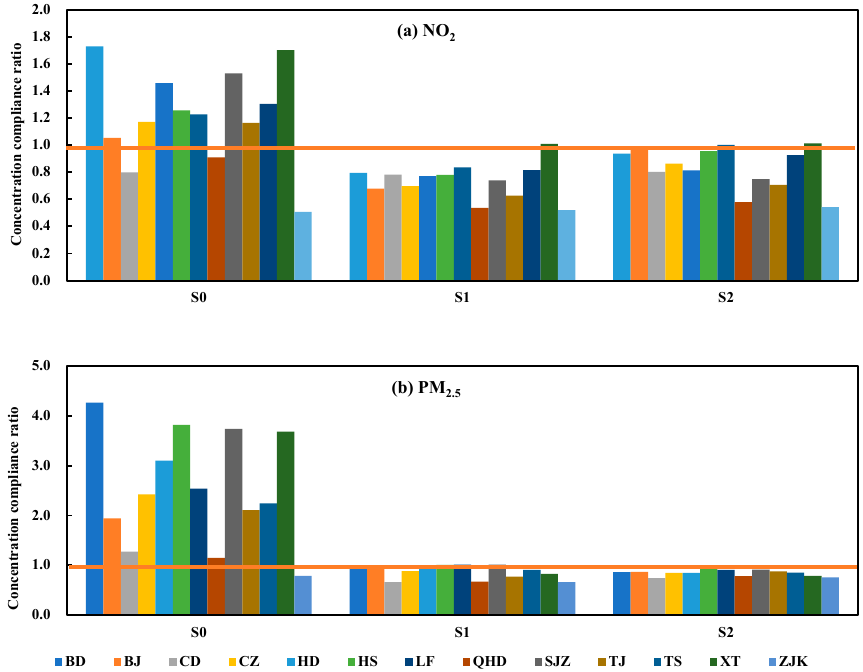
Figure 3. Concentration compliance ratios of two pollutants under different emission scenarios for every city (the orange line is the national air quality secondary standard; the concentration compliance ratio is equal to the concentration value of each city divided by the national secondary standard value).